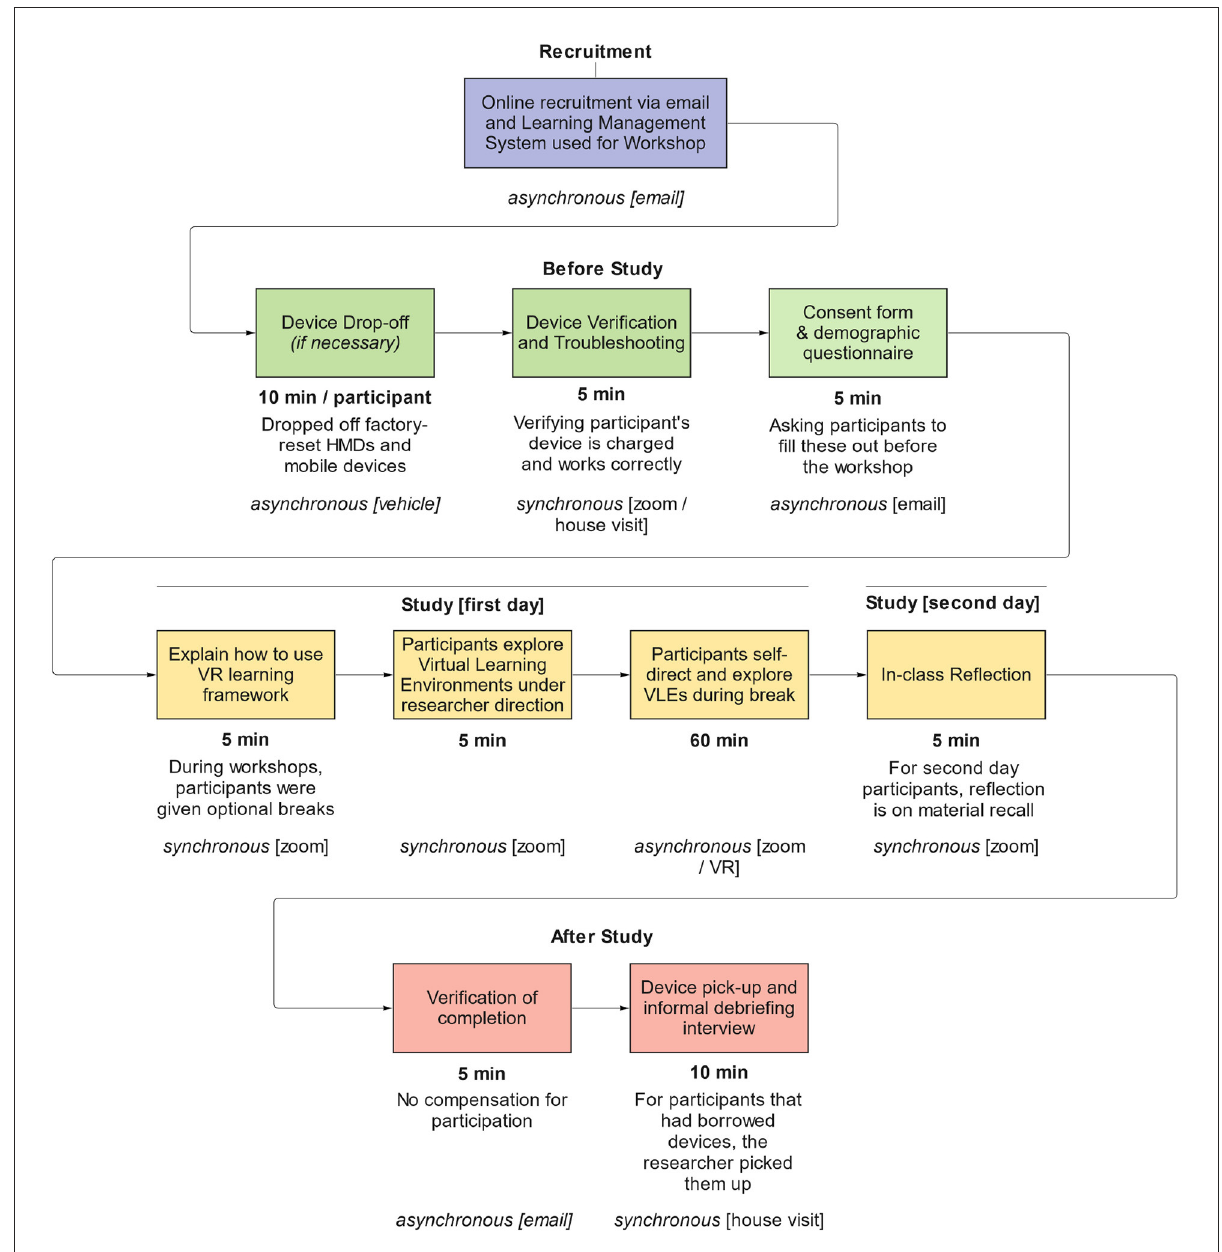
FIGURE6 Visualization of the study procedure for the women in trades diversity training VR learning activity